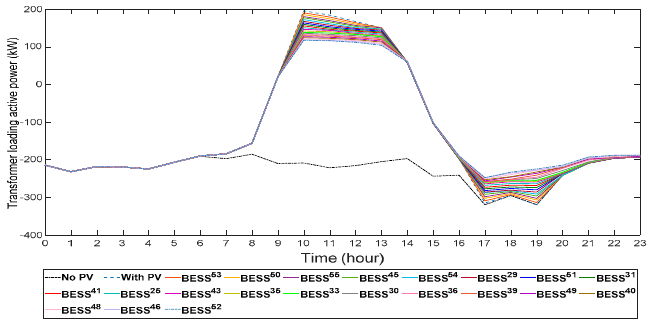
Figure 8. Transformer loading with different numbers of BESS.